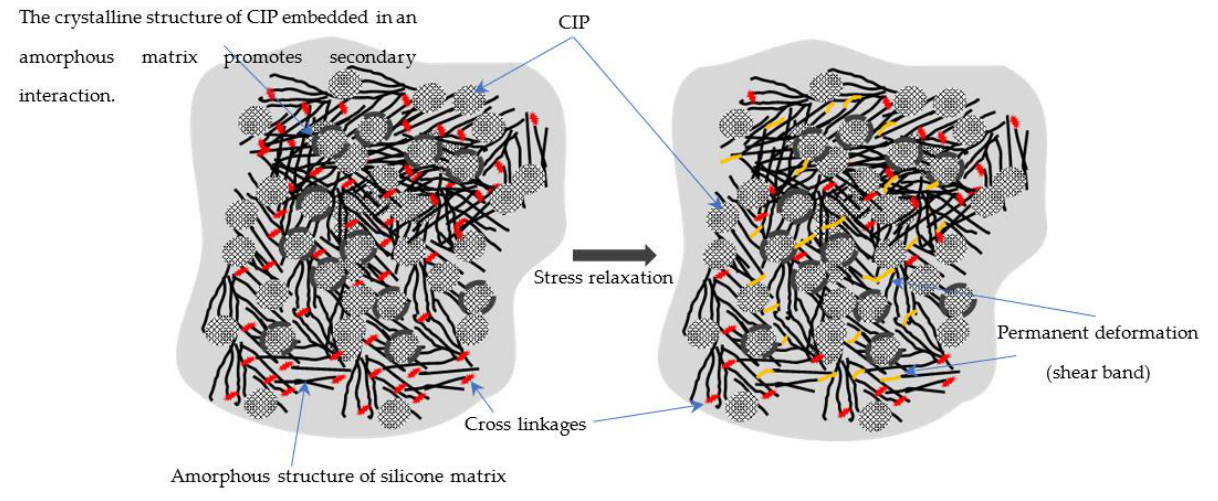
Figure 8. Schematic representation of CIPs, cross-linkages, and the matrix amorphous molecular chain undergoing stress relaxation resulting in permanent